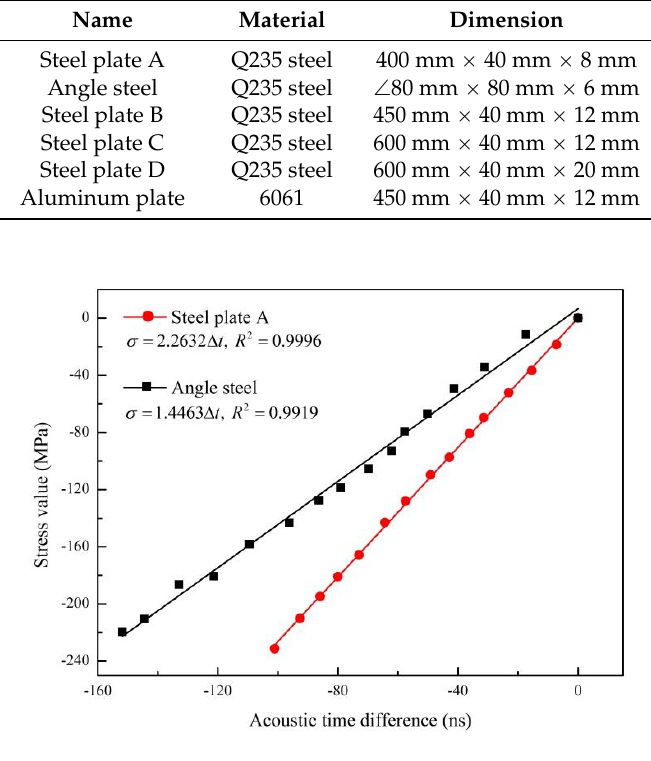
Figure 5. Fitting line between stress and TOF of steel plate A and angle steel. Table 3. Comparison between two methods of steel plate A and angle